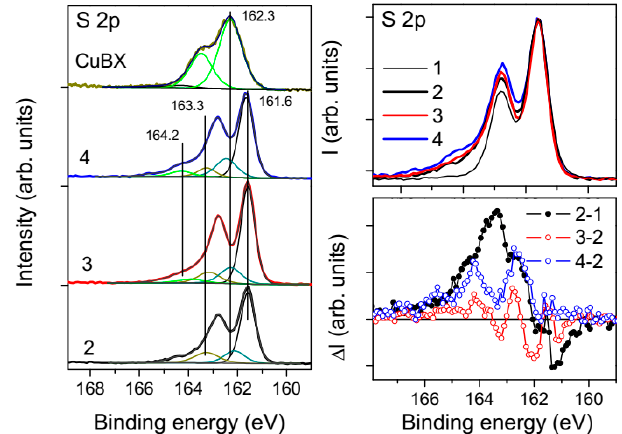
Figure 2. Cryo-XPS S 2p spectra from fast-frozen sphalerite (1) ground, (2) reacted with 0.1 mM CuSO 4 , the activated mineral treated with (3) 0.1 mM KBX and (4) 10 mM KBX. Right panels show the bands, normalized by the height and shifted to align the peak position, and the differences between the spectra. For clarity, only S 2p 3/2 components are shown in the S 2p spectra fitting. Reproduced from [102] with permission from Elsevier.